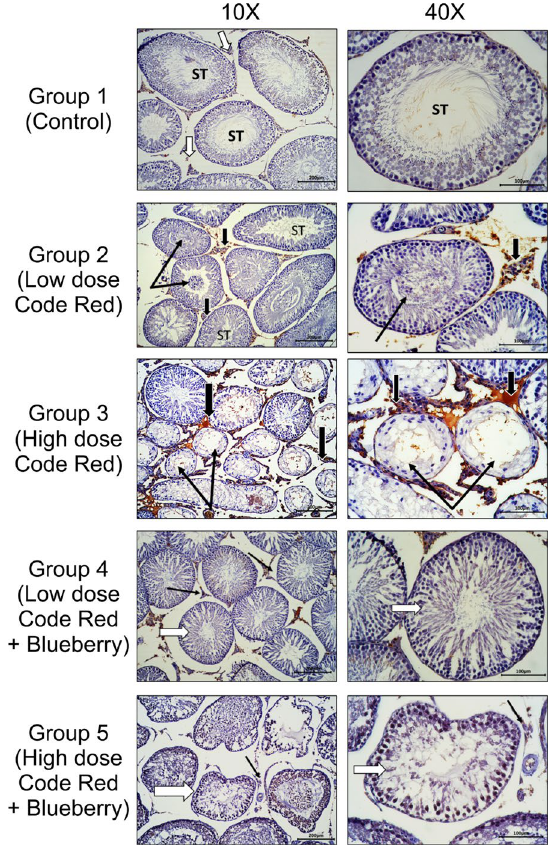
Fig. 2 Sections from rat testis immunostained for caspase‑3 (apoptotic marker) and photographed at 100 bar 200 µm × = and 200 bars 100 µm. Group 1 (Control): with negative × = immunostaining for caspase‑3 in seminiferous tubules (ST) except for mild reaction in interstitial tissue (white arrows). Group 2 (Low dose Code Red): showing desquamated germ cells within ST lumina (thin black arrows) and increased immunostaining for caspase‑3 in interstitial cells (thick black arrow). Group 3 (High dose Code Red): showing marked degenerative changes in most ST (Black arrows) and a marked increase in immunostaining for caspase‑3 in the degenerated germ cells (black arrows) as well as the interstitial cells (thick black arrows). Group 4 (Low dose Code Red Blueberry): + showing a marked decrease in caspase‑3 immunostaining in the interstitial cells (arrows) as well as germ cells (white arrows). Group 5 (High dose Code Red Blueberry) showed decreased caspase‑ 3 + immunoexpression, although some seminiferous tubules still showed deformity or germ cell desquamation (white